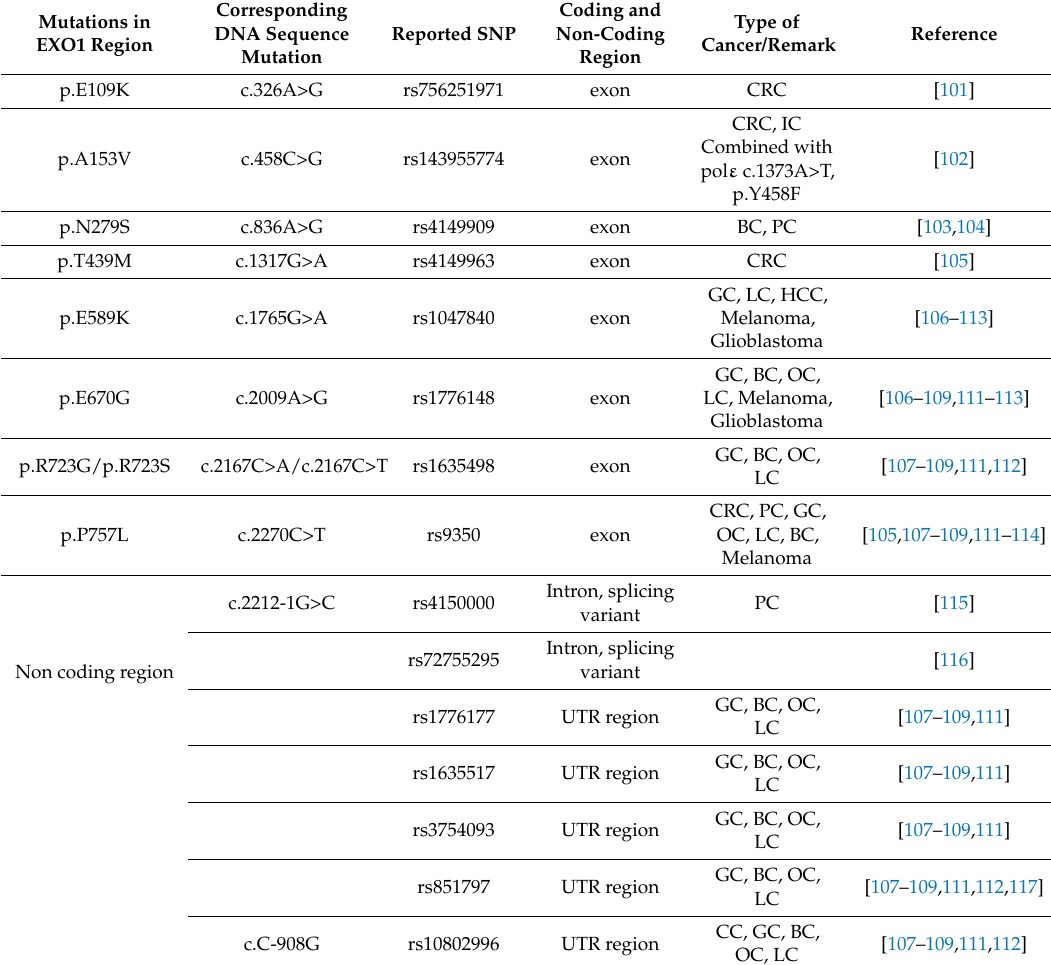
Table 2. Mutations in EXO1 in relation to different cancers. Represents the most commonly reported point mutations in EXO1 in relation to different cancer types. Abbreviations: CRC- colorectal cancer, IC- cancer of the small intestine, BC- breast cancer, PC- pancreatic cancer, GC- gastric cancer, LC- lung cancer, HCC- hepatocellular carcinoma, OC- oral cancer, and CC- cervical